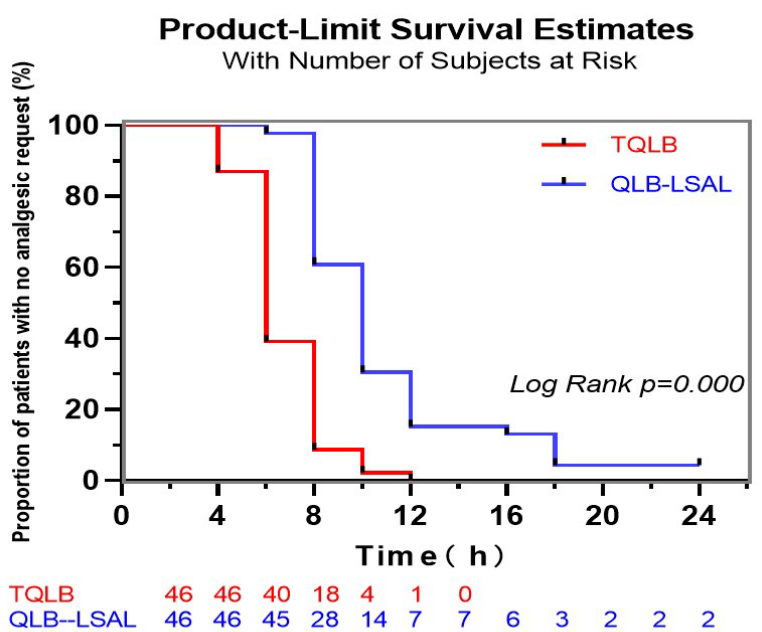
Figure 4. Kaplan–Meier estimate of time to first opioid administration. The participant’s ‘survival’ ended with the first opioid administration.